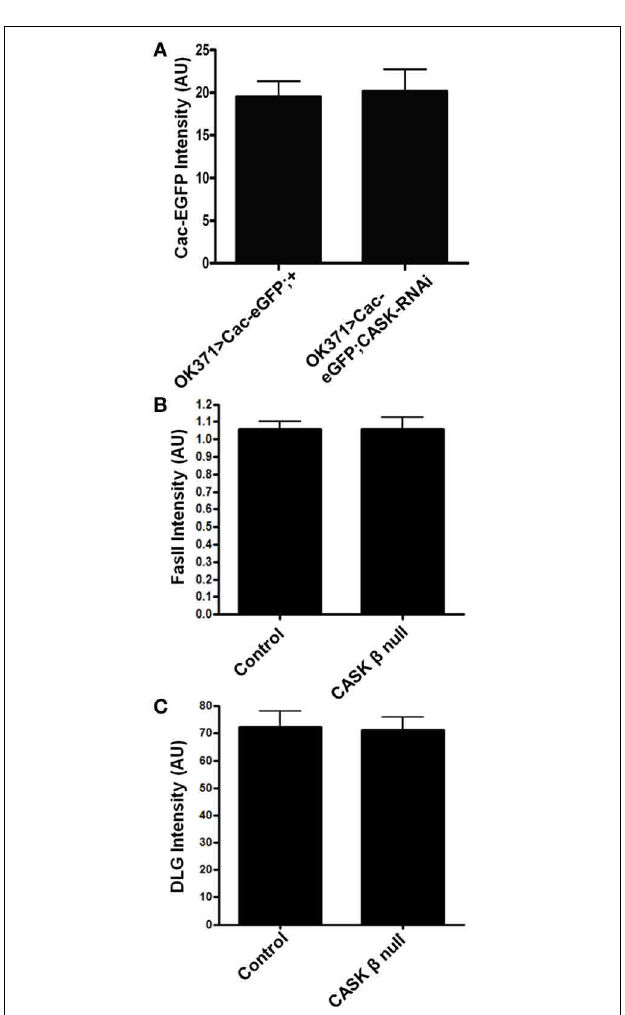
FIGURE 4 | CASK does not regulate the localization of Cav2, FasII, or DLG to synapses. (A) CASK knockdown had no effect on the intensity of Cac-EGFP at the NMJ compared to control ( p > 0 . 05, n = 6, unpaired t -test). (B) CASK β deletion did not significantly affect the intensity of FasII staining at the NMJ ( p < 0 . 05, n = 6, unpaired t -test). (C) CASK β deletion did not significantly affect the intensity of DLG staining at the NMJ ( p < 0 . 05, n = 6, unpaired t